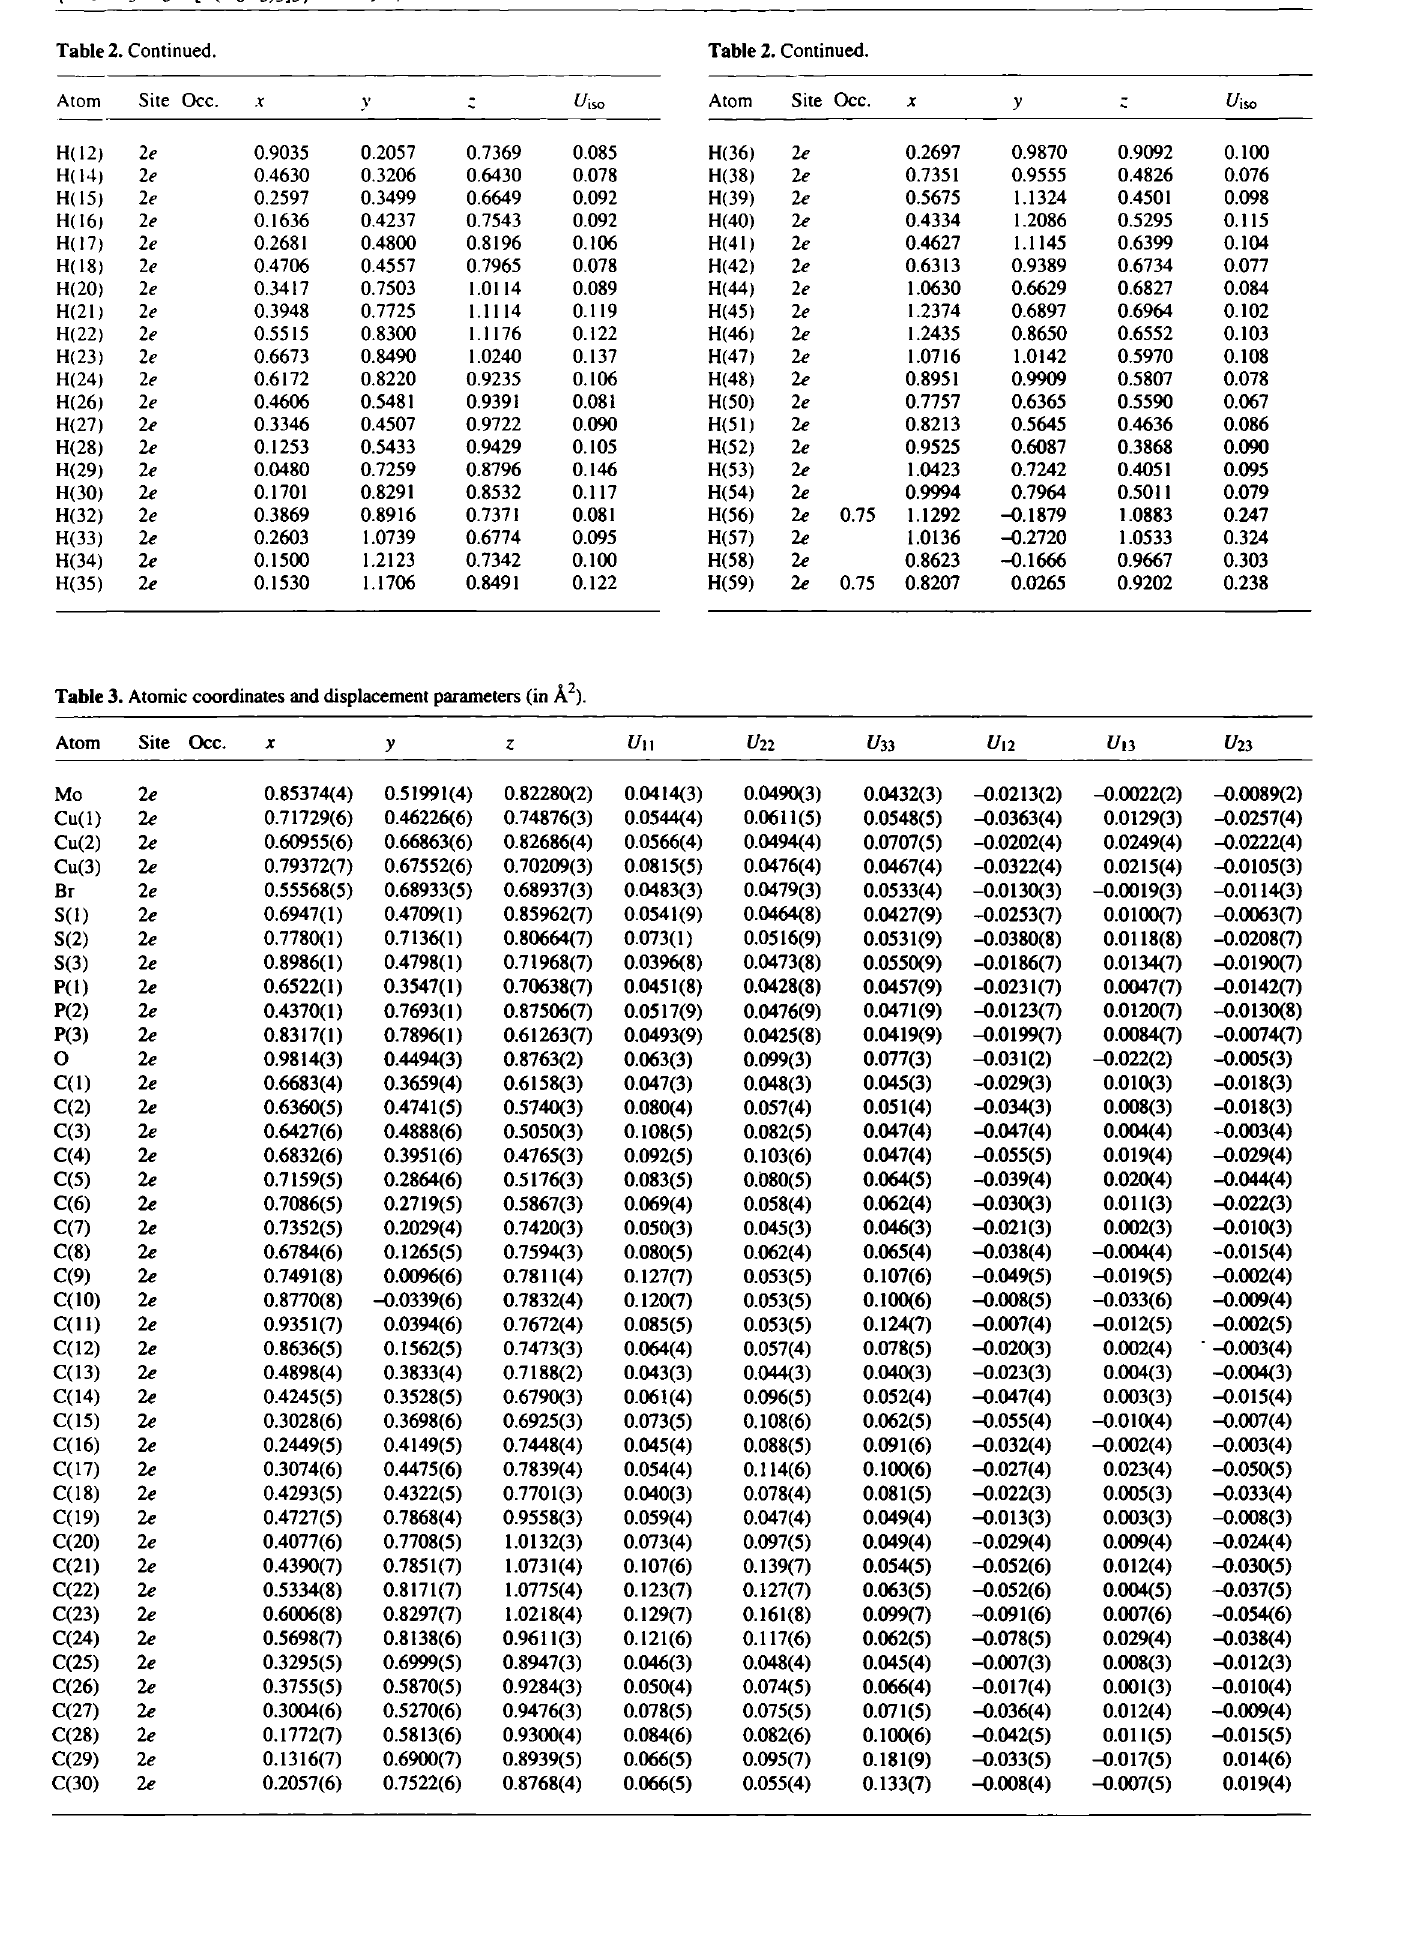
Table 3. Atomic coordinates and displacement parameters (in Â 2